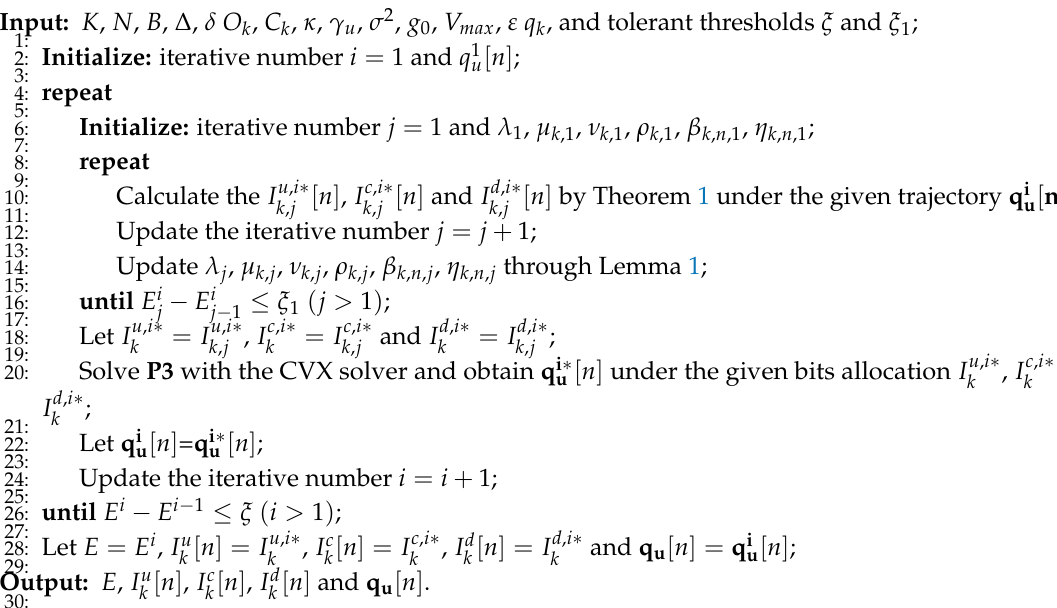
Algorithm 1 The alternating algorithm for